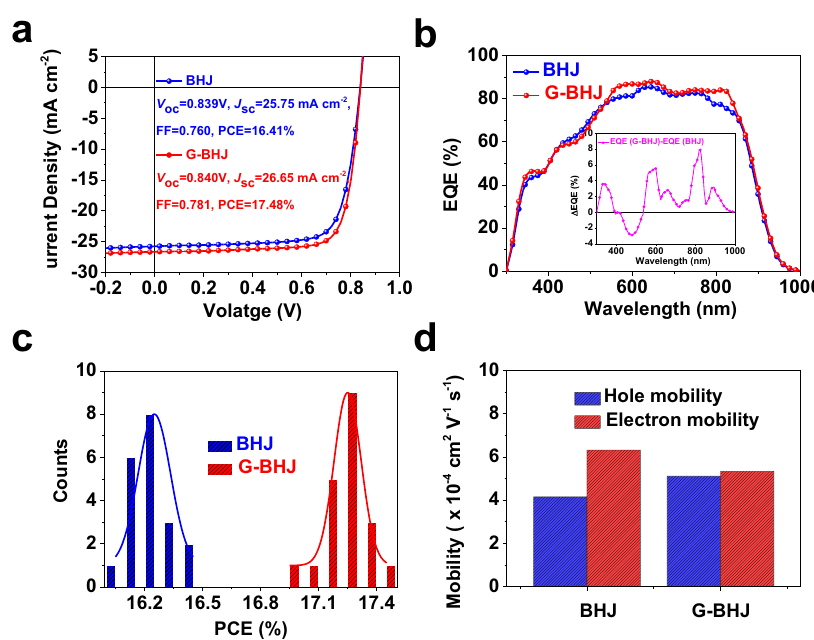
Fig. 2 Device performances. a J – V curves and b EQE response of best-performing BHJ and G-BHJ-based devices. c Histograms of the PCE counts for 20 optimal BHJ- and 20 optimal G-BHJ-based devices. d Histogram of hole and electron mobilities for BHJ and G-BHJ blends determined by SCLC